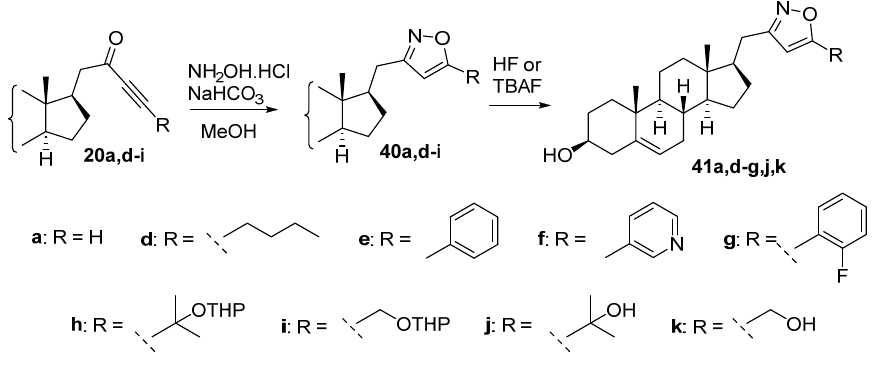
Table 1 . Compounds used for biological